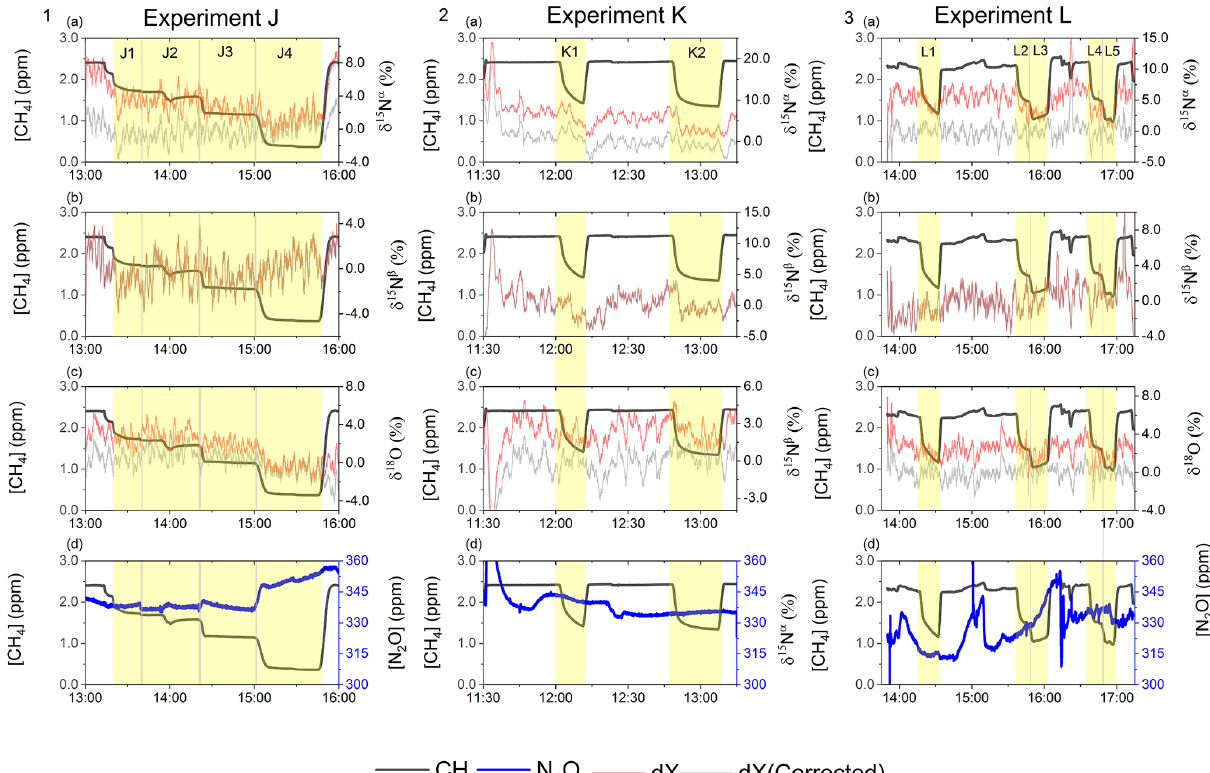
Figure D3. Results from the three experiments J, K and L using the G5131-i for N 2 O isotope measurements. The CH 4 level is depicted in each row (ppm) along the first y axis. Highlights indicate the several different oxidation settings. Row 1: measurements of δ 15 N α (‰) plotted along the second y axis. Red highlights a 100s average measured value corrected for O 2 , CO and CO 2 effects, while grey indicates a 100s average value that has been corrected for all interference including CH 4 . Row 2: measurements of δ 15 N β (‰) plotted along the second y axis. Red highlights a 100s average measured value corrected for O 2 , CO and CO 2 effects, while grey indicates a 100s average value that has been corrected for all interference including CH 4 . Row 3: measurements of δ 18 O (‰) plotted along the second y axis. Red highlights a 100s average measured value corrected for O 2 , CO and CO 2 effects, while grey indicates a 100s average value that has been corrected for all trace gas interference including CH 4 . Row 4: measurements of [N 2 O] (ppb) shown in blue. Variation observed corresponds to fluctuations in the mixing of the three gases. Exp. J: in this experiment the light was turned on throughout the entire experiment, with the experimental steps corresponding to changes in t R . Exp. K: in this experiment two experimental steps were used with different power settings. Exp. L: in this experiment the sofnocat trap was used in the first three experimental steps, while steps 4 and 5 were completed without. The variation between experimental steps corresponds to changes in t R